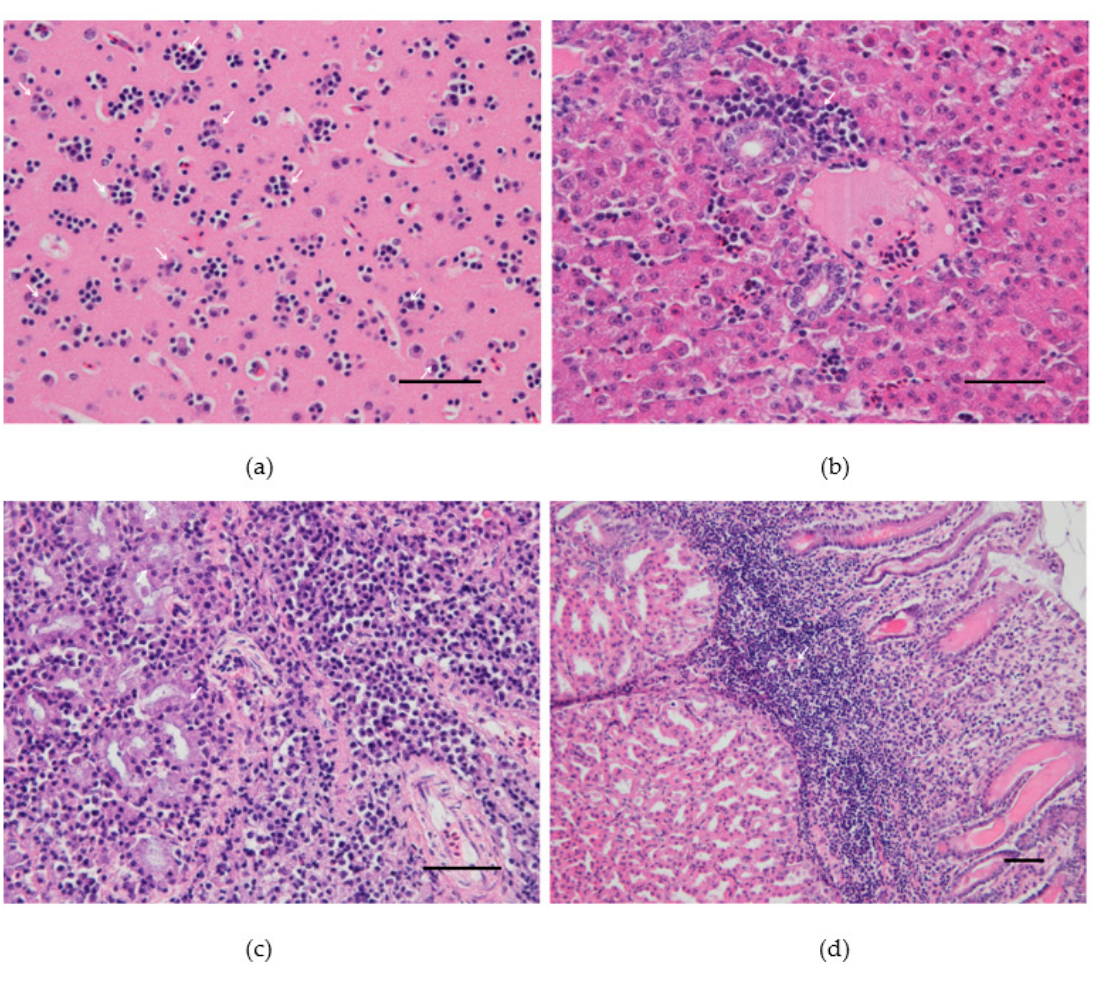
Figure 2. Pathological findings in the canary number 4 experimentally infected with 10 6 TCID 50 of Usutu virus: ( a ) Cerebral cortex. Satellitosis: multiple foci of neuroglia around degenerating/apoptotic neurons. ( b ) Liver. Periportal hepatic inflammation: accumulation of lymphocytes, plasma cells, heterophils, and macrophages mostly around the portal area. ( c ) Lachrymal gland. Necrotic epithelial cells and massive lymphocytic and plasmacytic infiltrations within the interstitium. ( d ) Proventriculus. Marked lymphoplasmacytic and histiocytic infiltrates in the lamina propria. Hematoxylin and eosin, Scale bars: 50 µm.